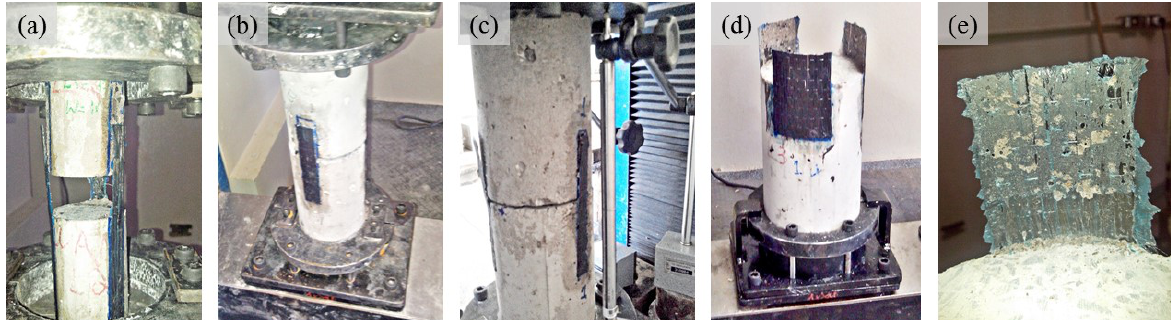
Figure 7. Experiments with debonding failure between concrete and FRP: a) FRP geometry G01 and 50 mm × 100 mm specimens; b) FRP geometry G02 and 100 mm × 200 mm specimens; c) FRP geometry G01 and 100 mm × 200 mm specimens;